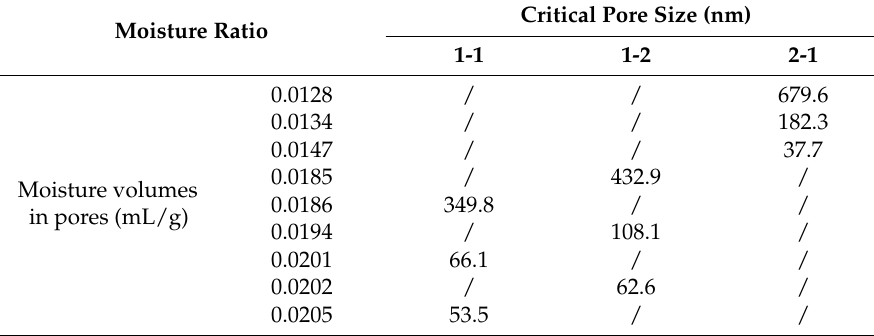
Table 7. Moisture volumes within pores and corresponding critical pore